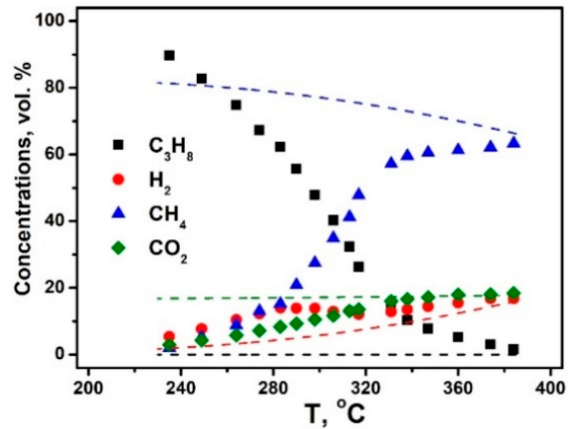
Figure 1. The outlet concentrations of propane, methane, carbon dioxide, and hydrogen (on the dry basis) as a function of temperature during propane pre-reforming. Experimental conditions: 240–400 ◦ C, GHSV 12,000 h − 1 , 1 bar pressure, reaction mixture: 25 vol.% C 3 H 8 , 75 vol.% H 2 O. Points are experimental. Dashed lines are equilibrium concentrations.